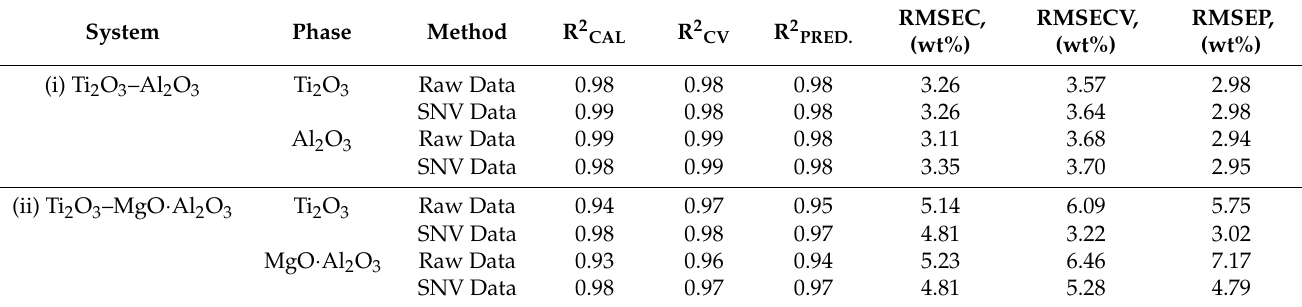
Table 6. Estimated figures of merit for calibration and validation using the PLS models for (i) Ti 2 O 3 –Al 2 O 3 and (ii) Ti 2 O 3 –MgO · Al 2 O 3 .